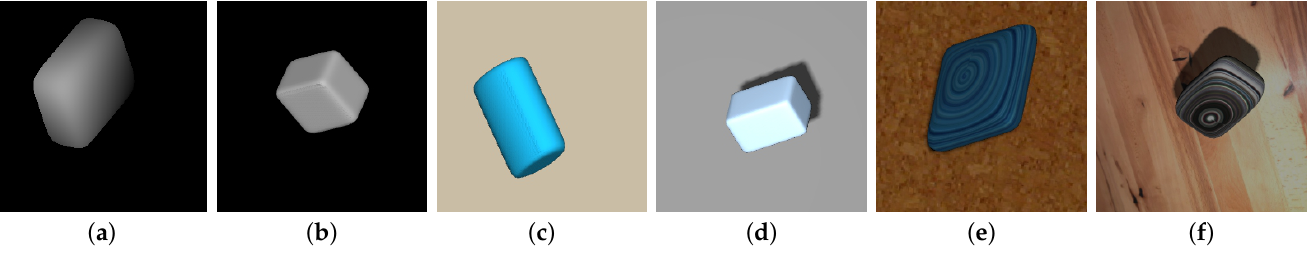
Figure 5. Various images of superquadrics (SQs) generated by the renderer present in Figure 1. ( a ) Depth image; ( b ) intensity image; ( c ) color image; ( d ) color image with shadows; ( e ) textured SQ and background; ( f ) textured SQ on wood with